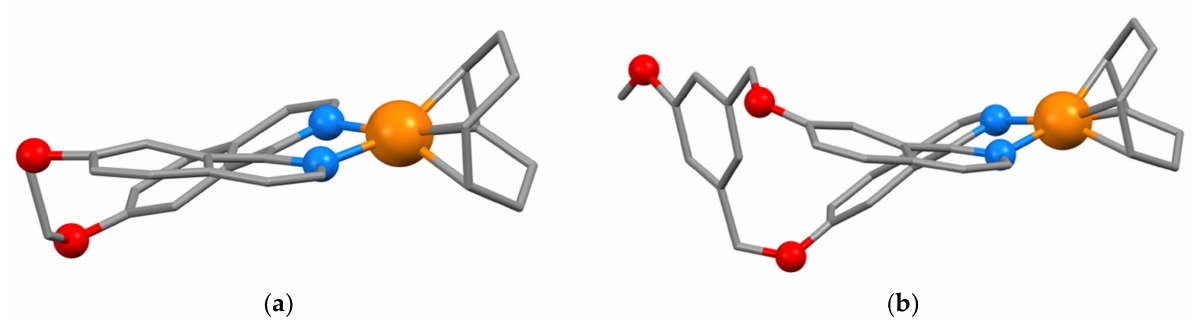
Figure 13. ( a ) The structure of the [Rh{(1 M )- 7 }(cod)] + cation found in [Rh{(1 MP )- 7 }(cod)](ClO 4 ) · Me 2 CO with hydrogen atoms omitted for clarity and non-carbon atoms as balls; ( b ) the structure of the [Rh{(1 M )- 8 }(cod)] + cation found in [Rh{(1 M )- 8 }(cod)](ClO 4 ) · Me 2 CO with hydrogen atoms omitted for clarity and non-carbon atoms as